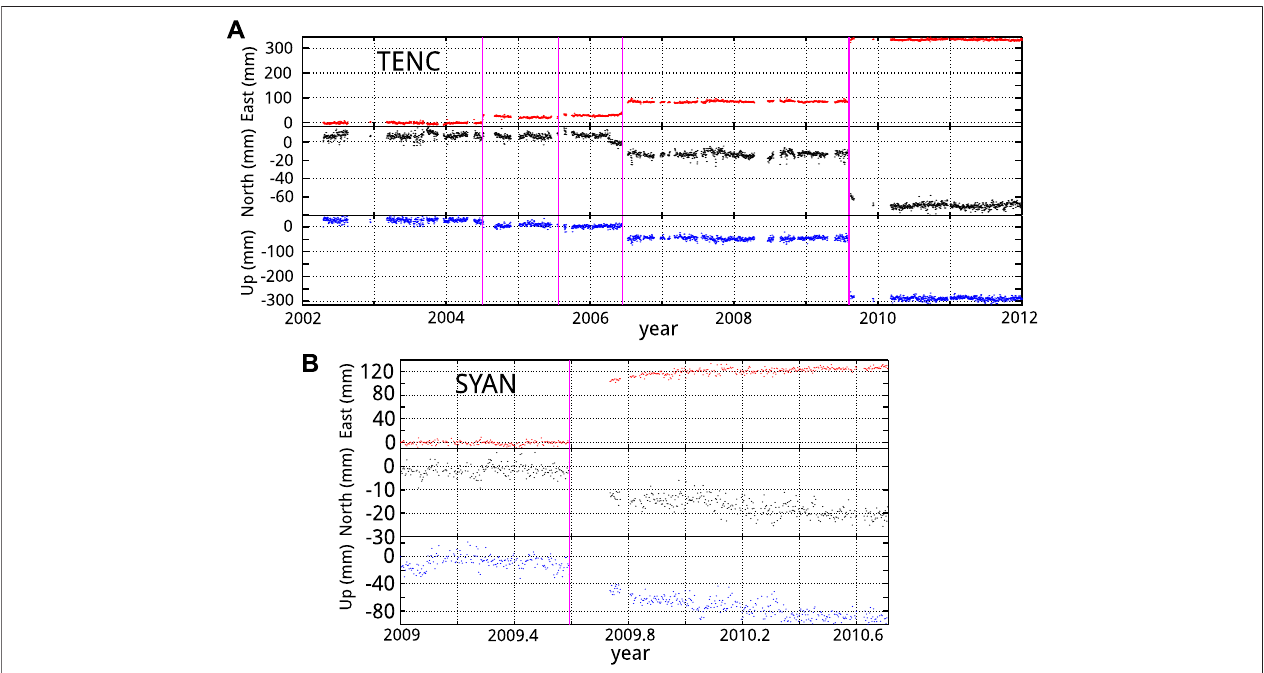
FIGURE 3| Residual GPSposition time series of (A) TienChih and (B) SiangYang landslide areas. The vertical magenta lines mark the landslide events: 6/29/2004 (Month/Day/Year) Mindulle typhoon, 7/18/2005 Haitang typhoon, 5/17/2006 heavy rainfall and 8/7/2009 Morakot typhoon. Note that the horizontal time axes are on different scales.